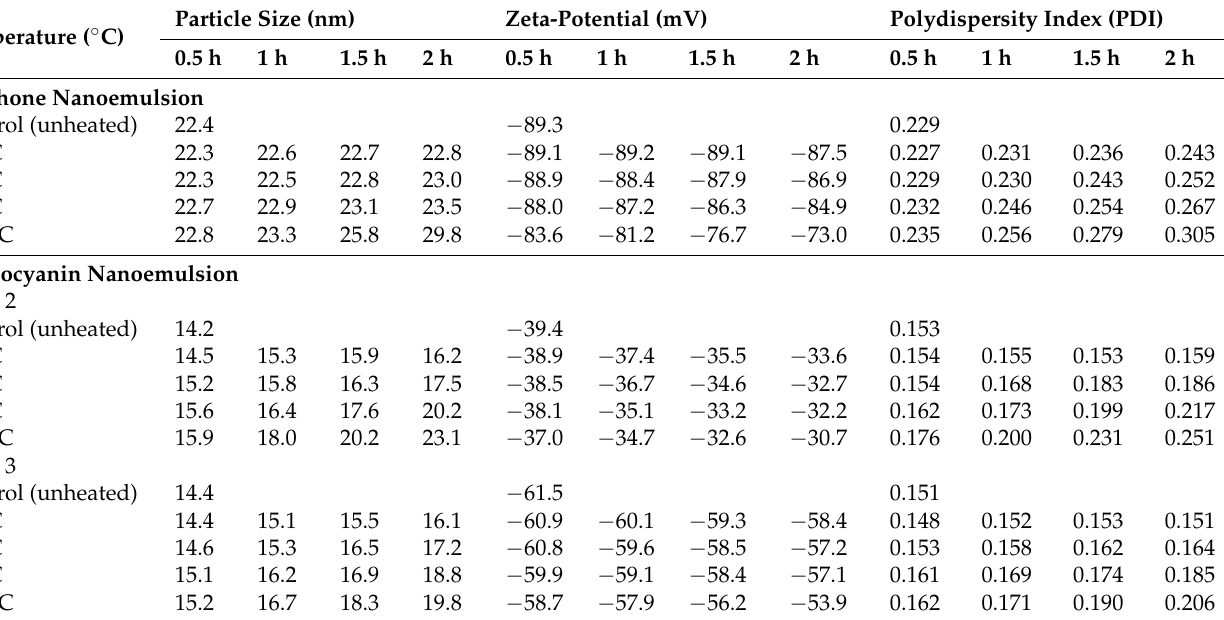
Table 3. Particle size, zeta-potential and polydispersity index change as affected by xanthone and anthocyanin nanoemulsion during heating at different temperatures (40–100 ◦ C) for varied length of time (0.5–2.0